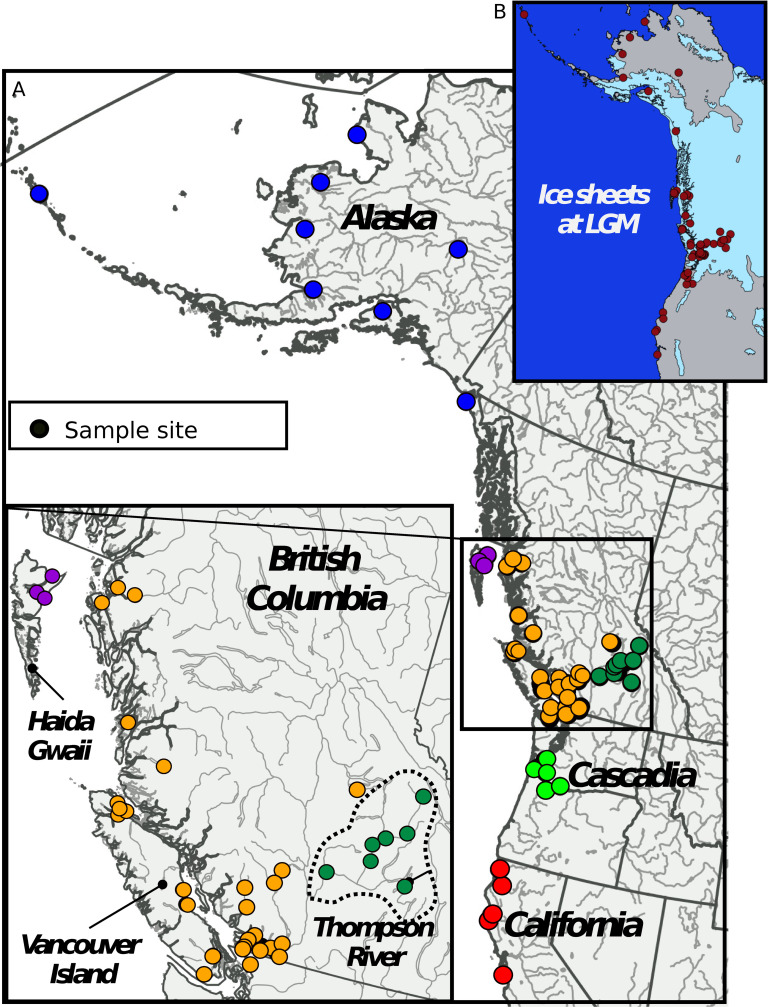
Sampling design.A) Sampling locations of 58 Coho salmon populations distributed across the species’ North American range. Each dot represents a sampling location. B) Map showing the extent of ice-sheet during the Last Glacial Maximum 13 Kya. Map drawn with Qgis software using data from [94, 95].